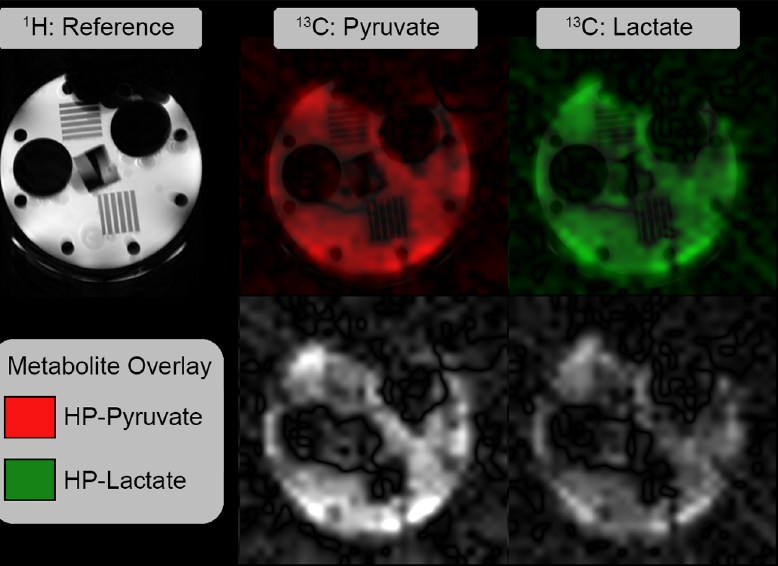
Figure 3. Spectroscopic images of the reaction carried out in a standard imaging phantom. Proton imaging (top left) shows the phantom structure in high resolution. Spectroscopic imaging data acquired using a radial EPSI sequence allows metabolite-specific visualization of tracer distribution (bottom row). Spectroscopic data can be intrinsically registered to high-resolution proton images (top center and right). doi:10.1371/journal.pone.0071274.g003 PLOS ONE |